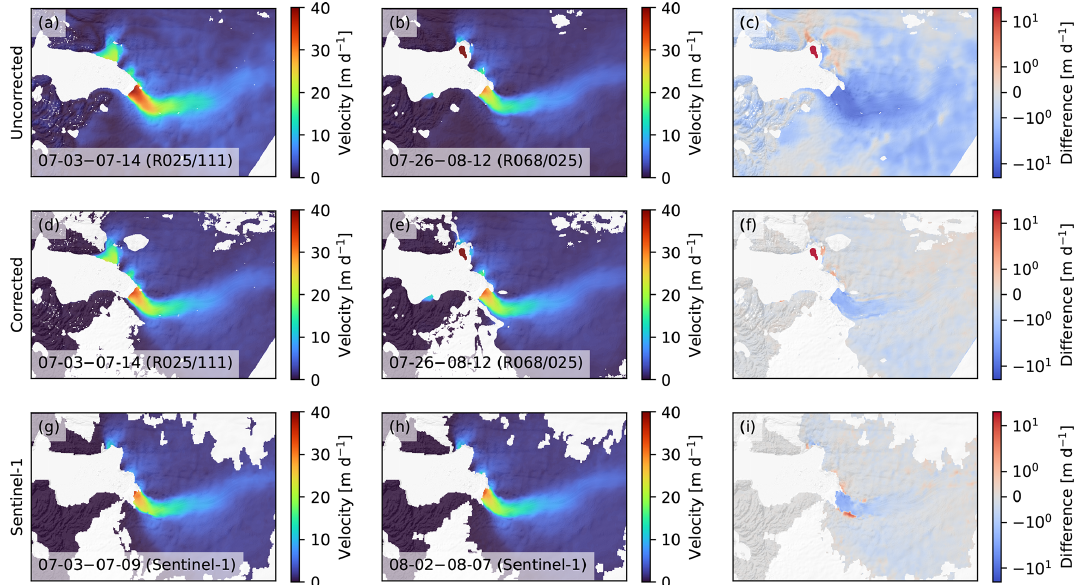
Figure 5. Velocity difference maps at Jakobshavn over a period of summer slowdown in 2019 (see Figs. 6 and 7). (a) Velocity field pre- slowdown, from uncorrected Sentinel-2 feature tracking. (b) Velocity field post-slowdown, from uncorrected Sentinel-2 feature tracking. (c) Difference between pre- and post-slowdown from uncorrected Sentinel-2 feature tracking. (d–f) Same as (a–c) , but for corrected Sentinel- 2 feature tracking. (g–i) Same as (a–c) , but for contemporaneous Sentinel-1 speckle tracking. Note log scale used on difference maps. Backgrounds are GrIMP DEM hillshades (Howat et al.,